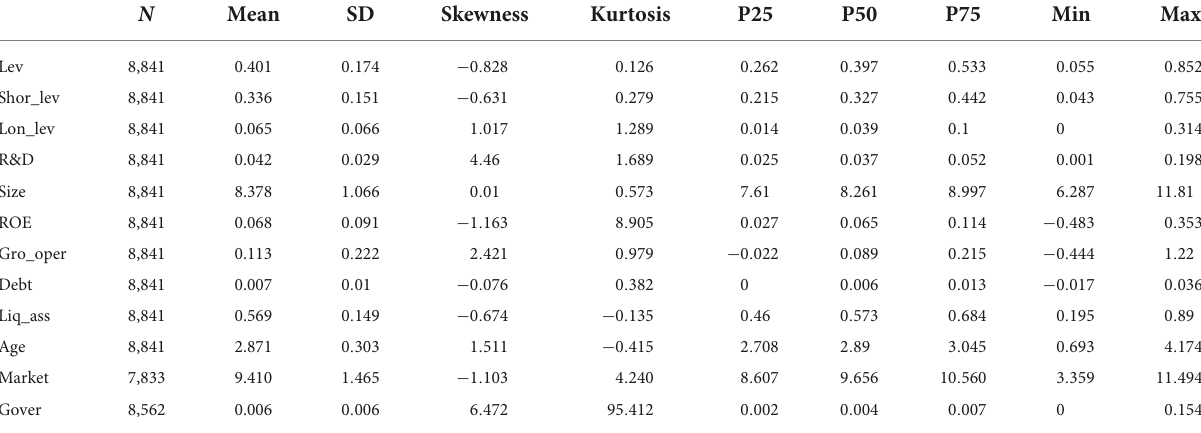
TABLE 2 Descriptive statistics of the